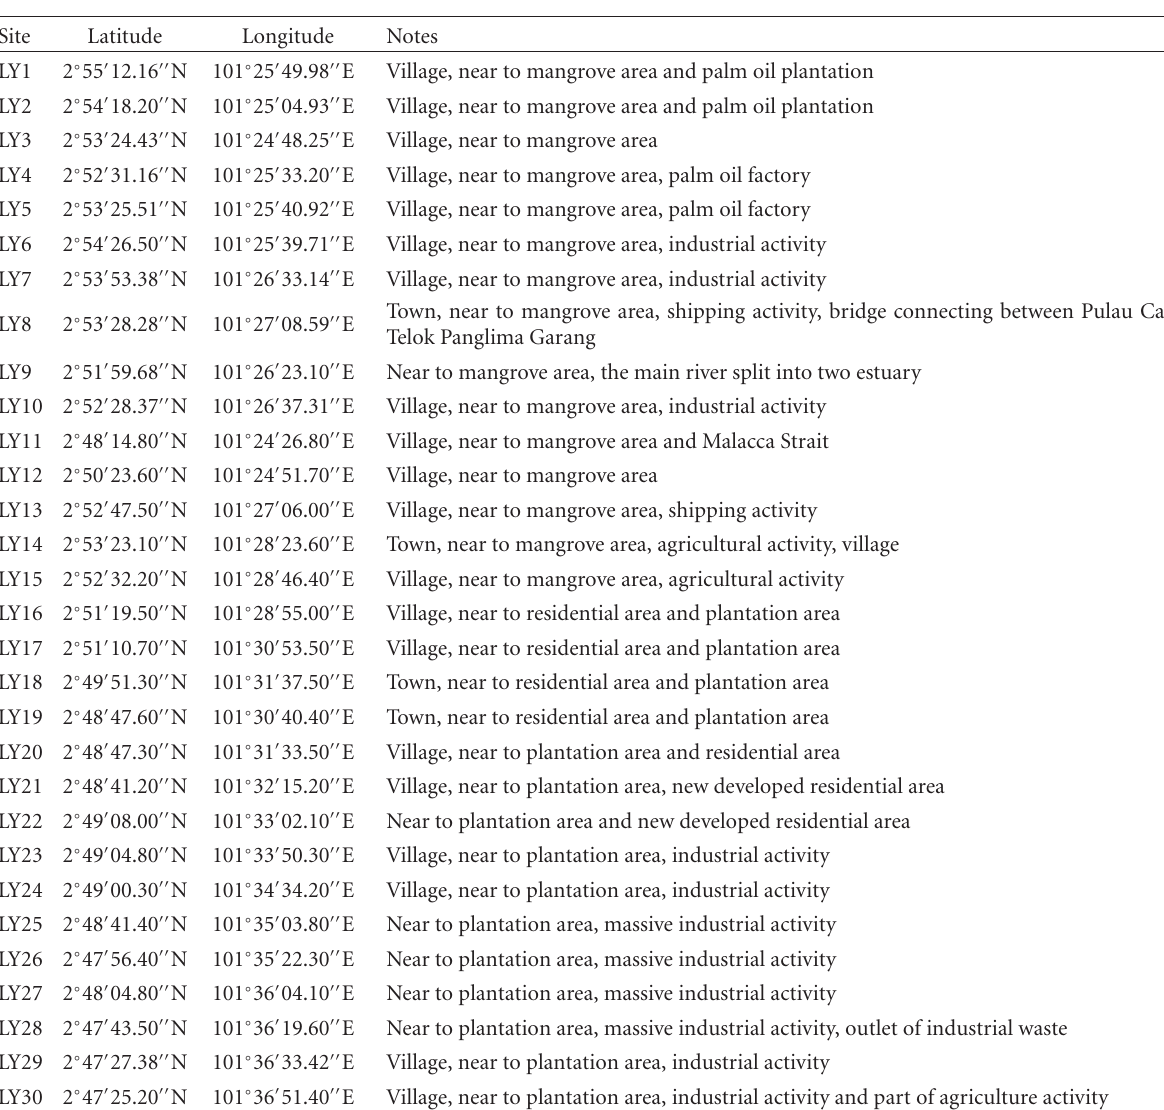
Table 1: The coordinate and notes of sampling stations.